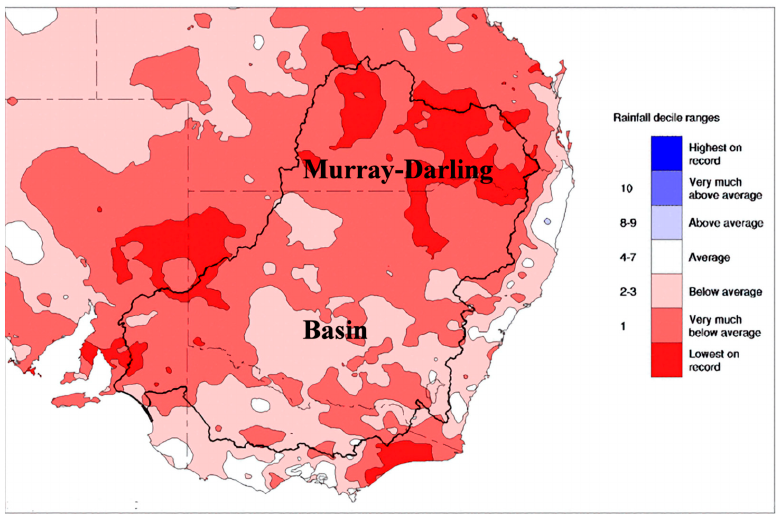
Figure 2. Murray-Darling Basin rainfall deciles. Rainfall deciles for the 48 months January 2017 to December 2020 in southeast Australia focusing on the MDB defined by the area within the solid black line. Note the lowest on record in the north of the basin and the very much below or below average rainfall in the rest of the basin. (Reproduced with permission under Creative Commons Attribution Licence 3.0 from the Australian Bureau of Meteorology). Available at: http://www.bom.gov.au/climate/maps/rainfall/?variable=rainfall&map=decile&period=48month&region=md&year=2020&month=12&day=31 (accessed 19 August 2022).